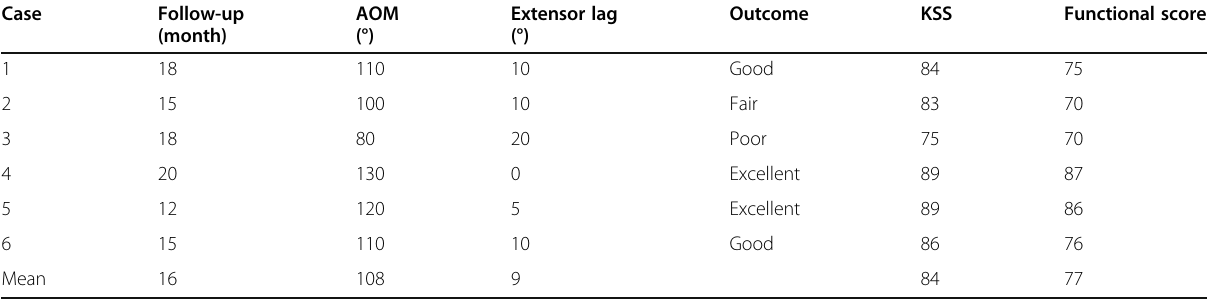
Table 2 Outcomes after one year Case Functional